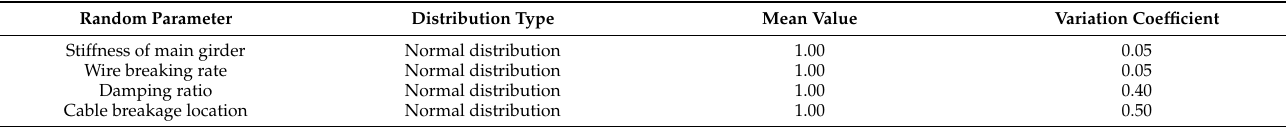
Table 6. Random parameter distribution types and values.